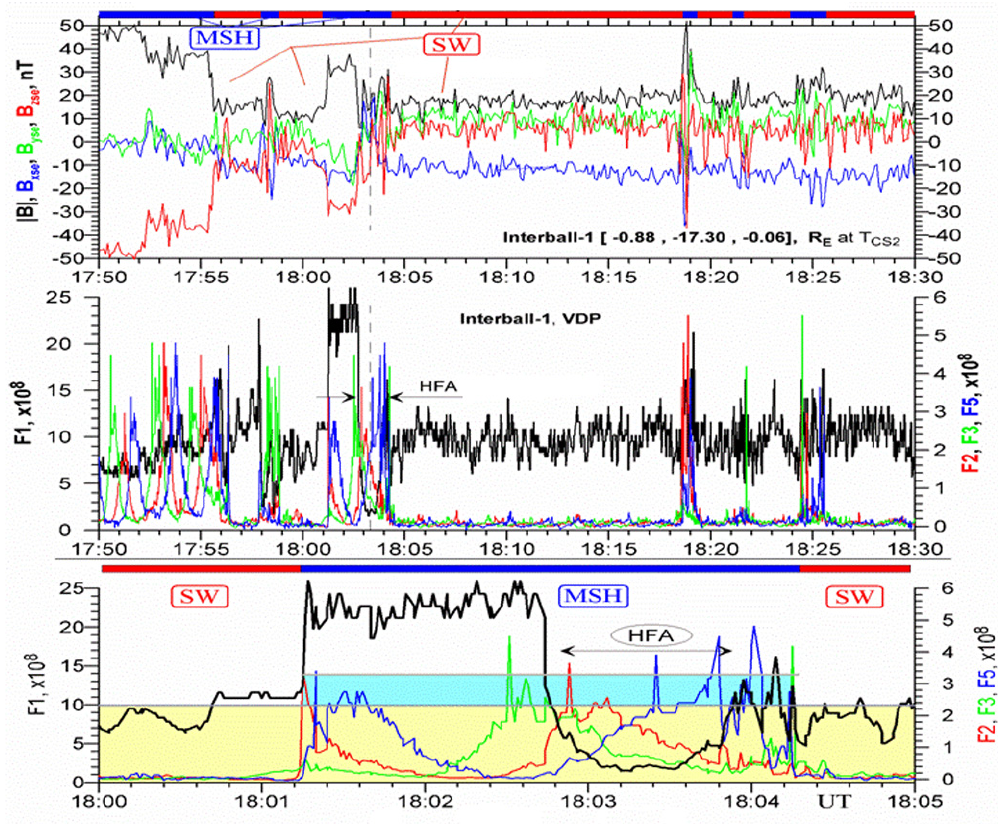
Fig. 1. Interball-1, 5 September 1995, Hot Flow Anomaly (HFA) and SPS observation (( − 0.9, − 17.3, − 0.1) R E in GSE at 18:03UT). Top panel: magnetic field intensity and components in GSE (see color code definition on the left). Middle panel: ion flux from 4 Faraday cups at 1Hz sampling in cm − 2 s − 1 . F1 from the Sun direction, F2, F3 and F5 (see color code definition on the right) transverse to the Sun-Earth line, rotating around this line with a 2min period. Bottom panel: blow-up of the middle panel around the HFA; yellow (cyan) shading shows the average sum of fluxes from the 4 Faraday cups in the SW (in the HFA and